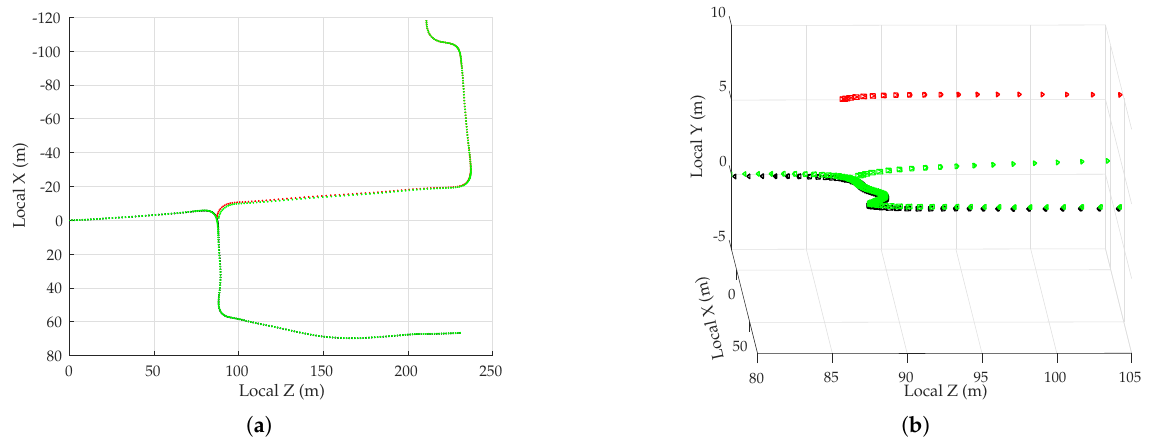
Figure 10. GEOSLAM trajectories after joint BA of current and prior keyframes (in green), overlaid on the corresponding (black and red) trajectories from Figure 8. ( a ) Top view of the trajectories. Note that both the current and prior keyframes (and map points, not shown) have been adjusted to optimally minimize the BA cost function over N m levels of covisibility. ( b ) View from 5 ◦